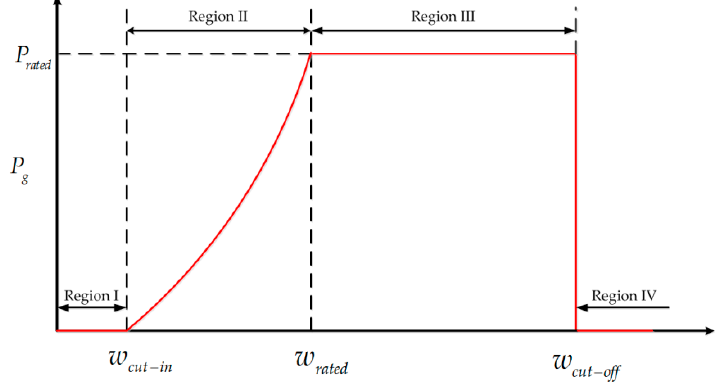
Figure 1. VSWT operation regions.